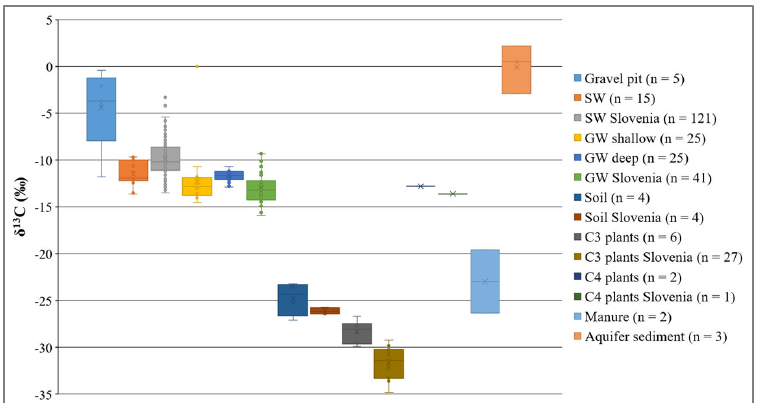
Figure 5. The δ 13 C of plants, soil, manure, aquifer sediment, δ 13 C DIC of SW and GW in the Varaždin aquifer area compared to the δ 13 C and δ 13 C DIC values (river water, groundwater) from the nearby Slovenian Sava study area [5,6,50,51] .